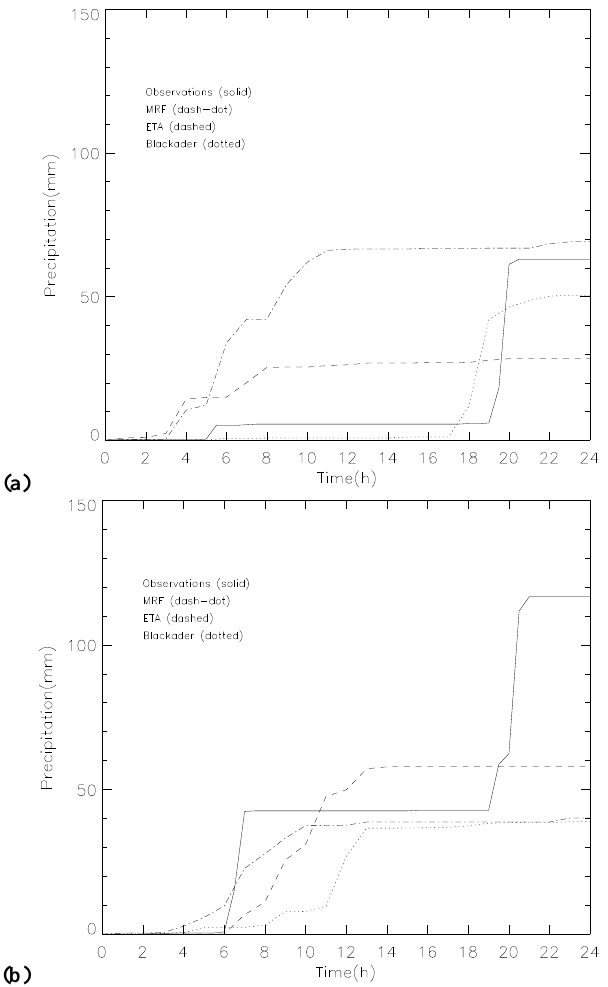
Fig. 8. Time evolution of the measured and calculated accumulated precipitation for 14 September 1999 at Fabra (a) and Vilassar (b) rain gauge stations. The observation (continuous line) are compared to the MRF (dash-dotted line), BLA (dotted line) and ETA (dashed line) PBL